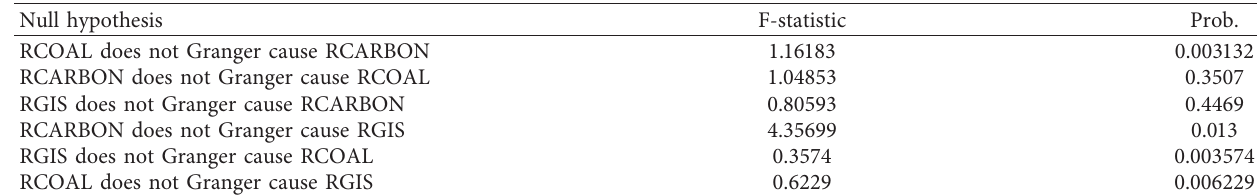
Table 8: Granger causality test of each